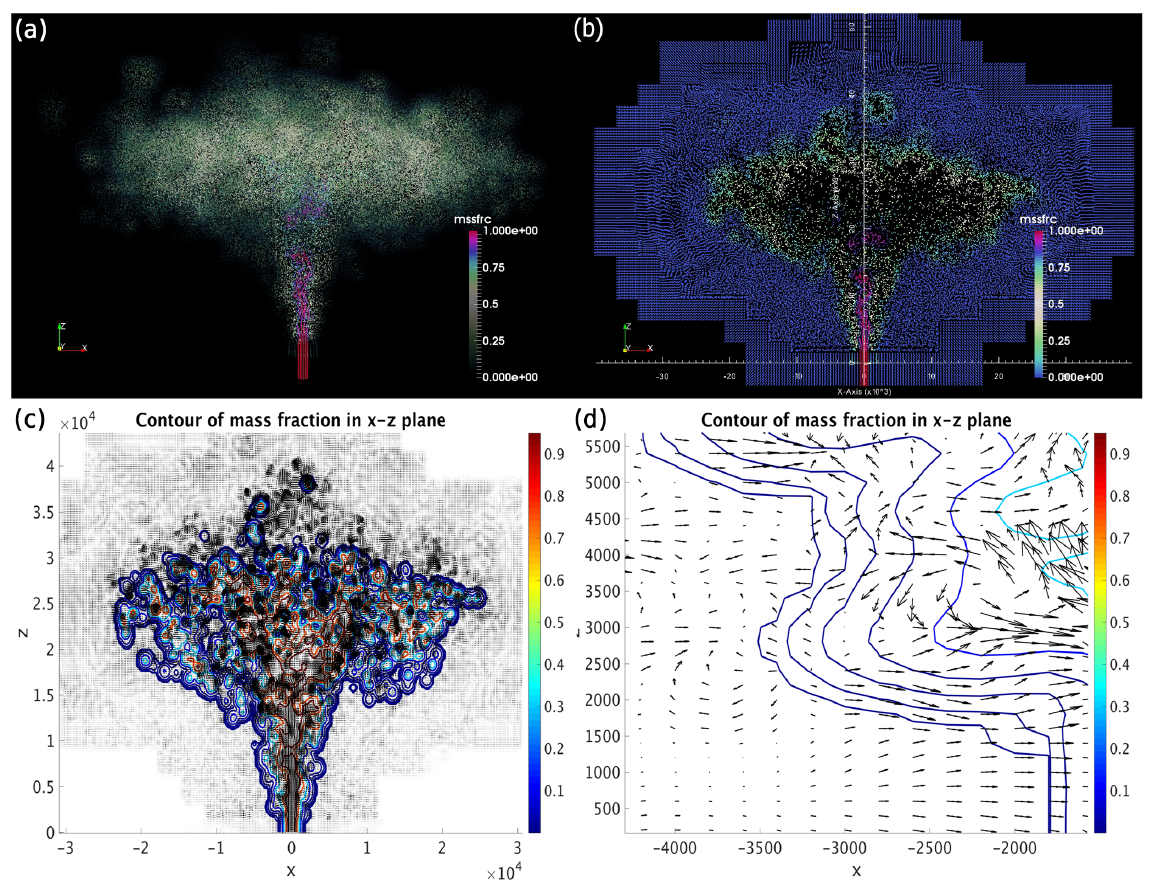
Figure 10. Mass fraction for t = 500s after eruption. Panels (a, b) are visualizations of SPH simulation results. Panel (b) shows visualization of a slice of the computational simulation, whose thickness is around 10000m. The lowest portion of the plume represents erupted material in the eruption vent (the underground portion). Panels (c, d) show the contour of the mass fraction and velocity quiver on an x − z plane. These panels are plotted utilizing postprocessed data (see Appendix A). The contour levels in the plot are 0.00001, 0.0001, 0.001, 0.1, 0.3, 0.75 and 0.95. Panel (d) is a zoomed view of velocity quiver showing plume expansion and entrainment of air.